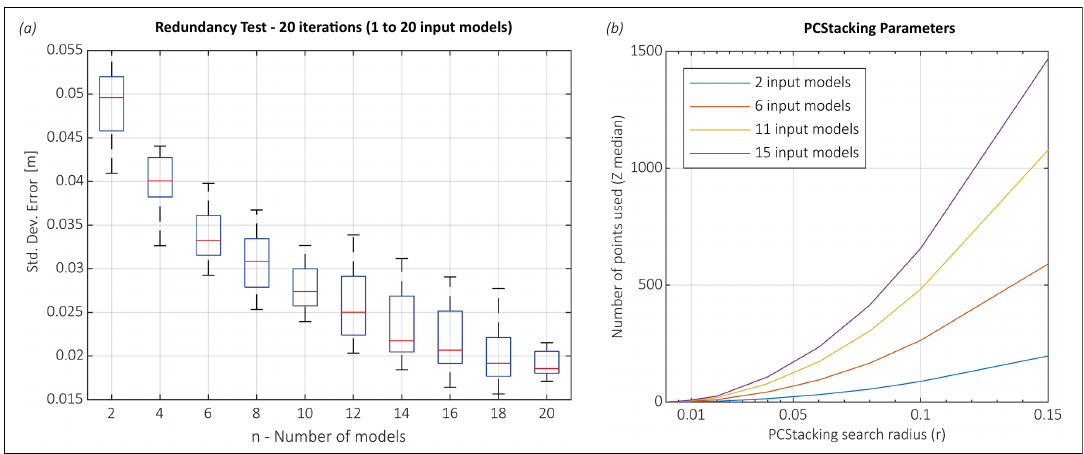
Figure 8. ( a ) Evolution of the standard deviation of the comparison Enh-PC n vs. Ref-PC in the redundancy test. The standard deviation decreased from 4.9 cm to 1.8 cm. A total of 400 Synt-PCs were used to compute this plot. ( b ) Number of averaged points according to the search radius (r). Each colored line represents a di ff erent number of Synt-PCs introduced into the PCStacking